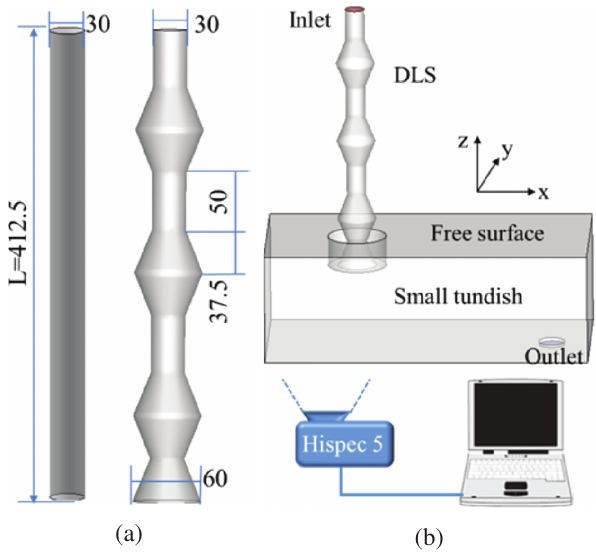
Figure 1: (a) Schemes and dimensions of studied ladle shrouds (the unit is mm for the listed values). (b) Experimental set-up and boundary conditions of the small